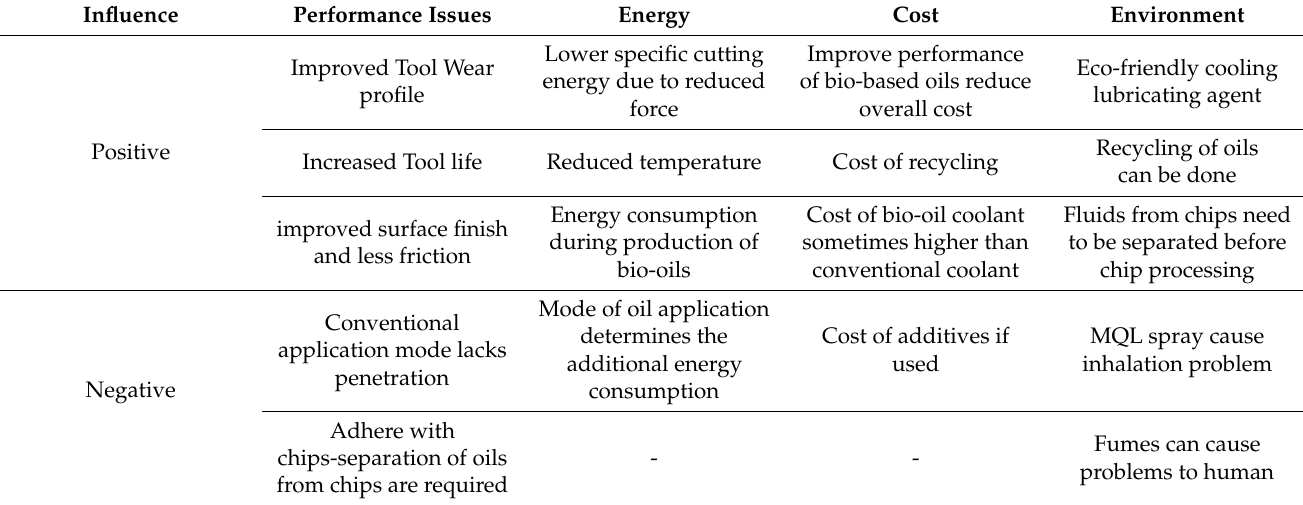
Table 11. A critical analysis of environmental aspects in bio-degradable oil aided machining, reprinted with permission from ref. [159]. Copyright 2019 Elsevier